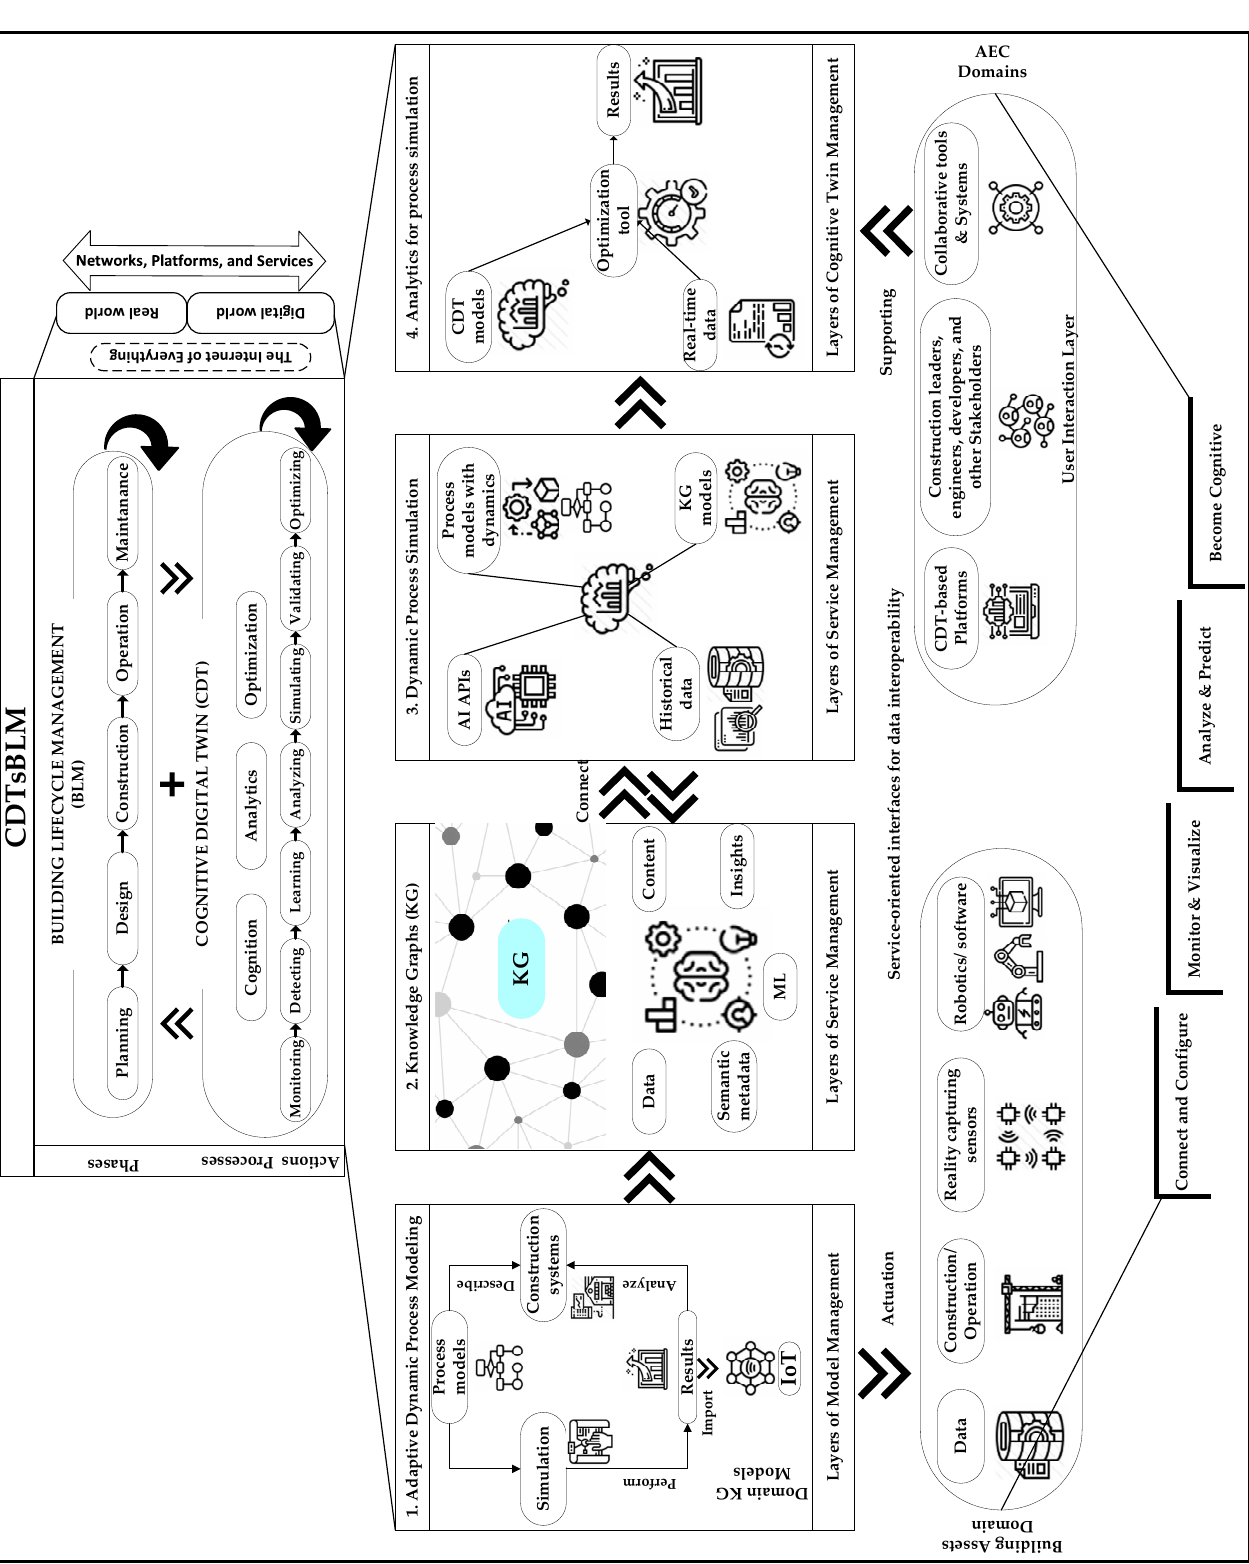
Figure 3. Knowledge Graph-centric Conceptual Framework of Cognitive Digital Twin for Building Lifecycle Management (CDTsBLM) (adapted from the developed framework by Lu et al. [48] and Abburu et al.